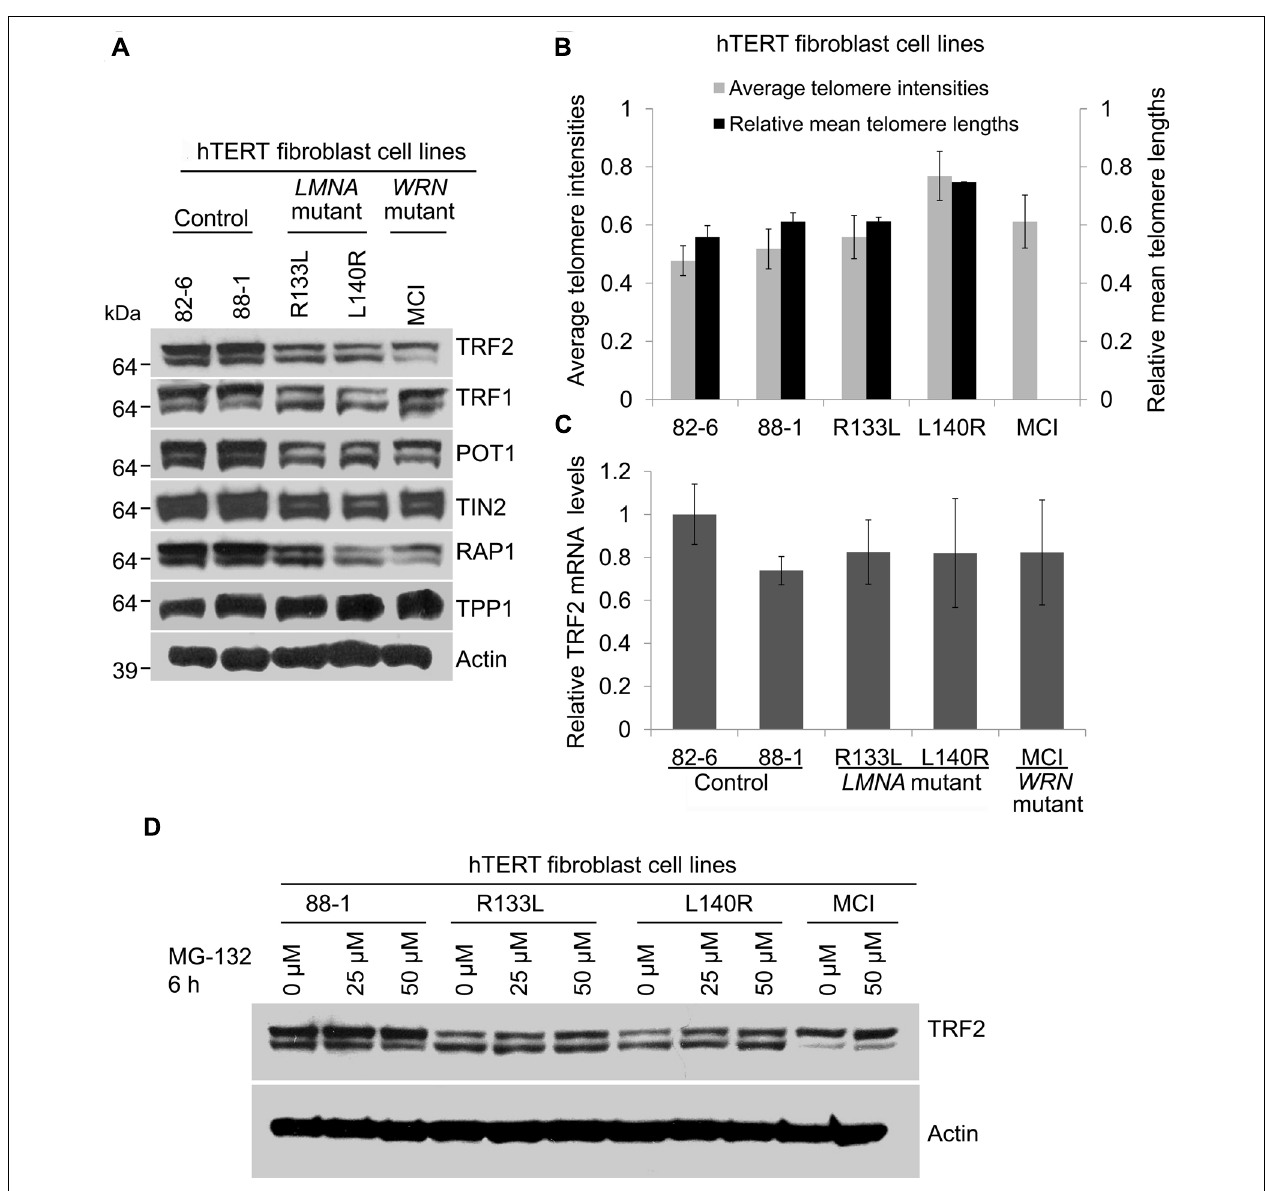
FIGURE 4 | Expression of shelterin subunits in hTERT-immortalized cell lines of control, LMNA mutant and WRN mutant fibroblasts. (A) Western analysis ofTRF2,TRF1, POT1,TIN2, hRap1, andTPP1 in hTERT-immortalized fibroblasts of indicated cell lines. Autoradiographies with higher exposures are shown for clarification of bands. (B) Analysis of relative telomere lengths expressed as average telomere intensities ± s.d. in indicated cell types, as shown in Figure 1 . A minimum of 70 cells were analyzed for each cell lines. Relative mean telomere lengths ( ± s.d.) were measured in hTERT-immortalized fibroblasts using qPCR. (C) TRF2 mRNA expression in